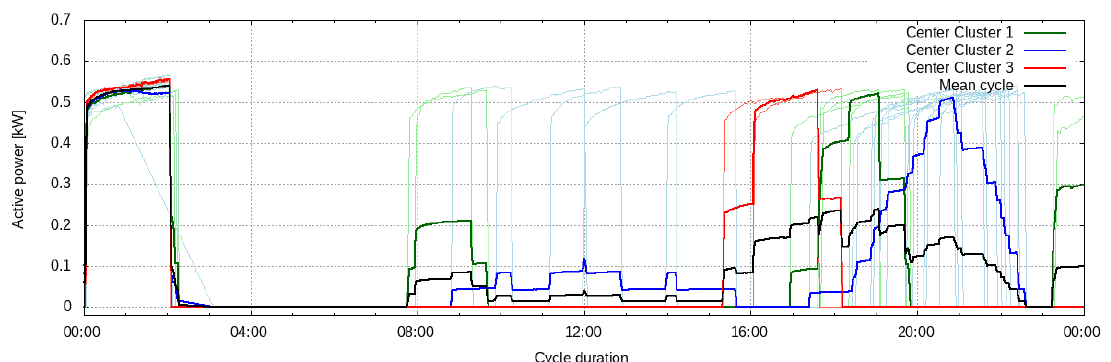
Figure 11. Clustered cycles and their corresponding cluster centers. The mean cycle used for prediction is computed from the cluster centers identified.